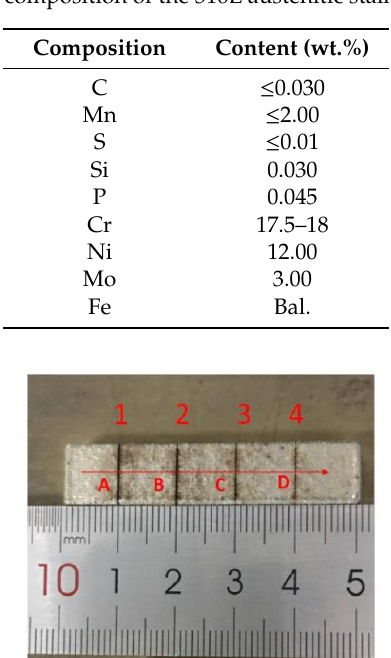
Table 1. Chemical composition of the 316L austenitic stainless-steel powder.